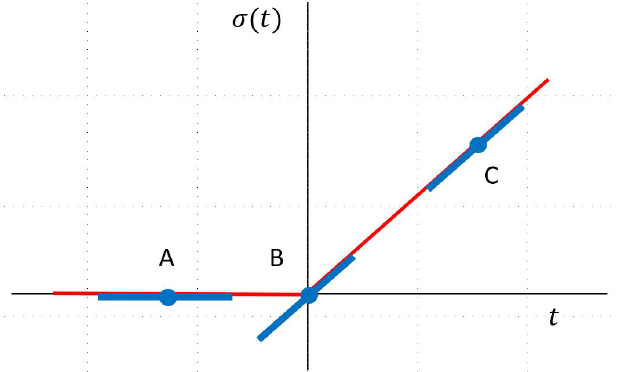
Figure 1. Illustration of LLA in Equation (4). The LLA algorithm is to approximate σ ( t ) by a local linear function iteratively, where t stands for a general argument and is replaced with x T w j + b j in the text. This figure illustrates the LLA of the ReLU activation function at points A, B and C with local linear functions around their